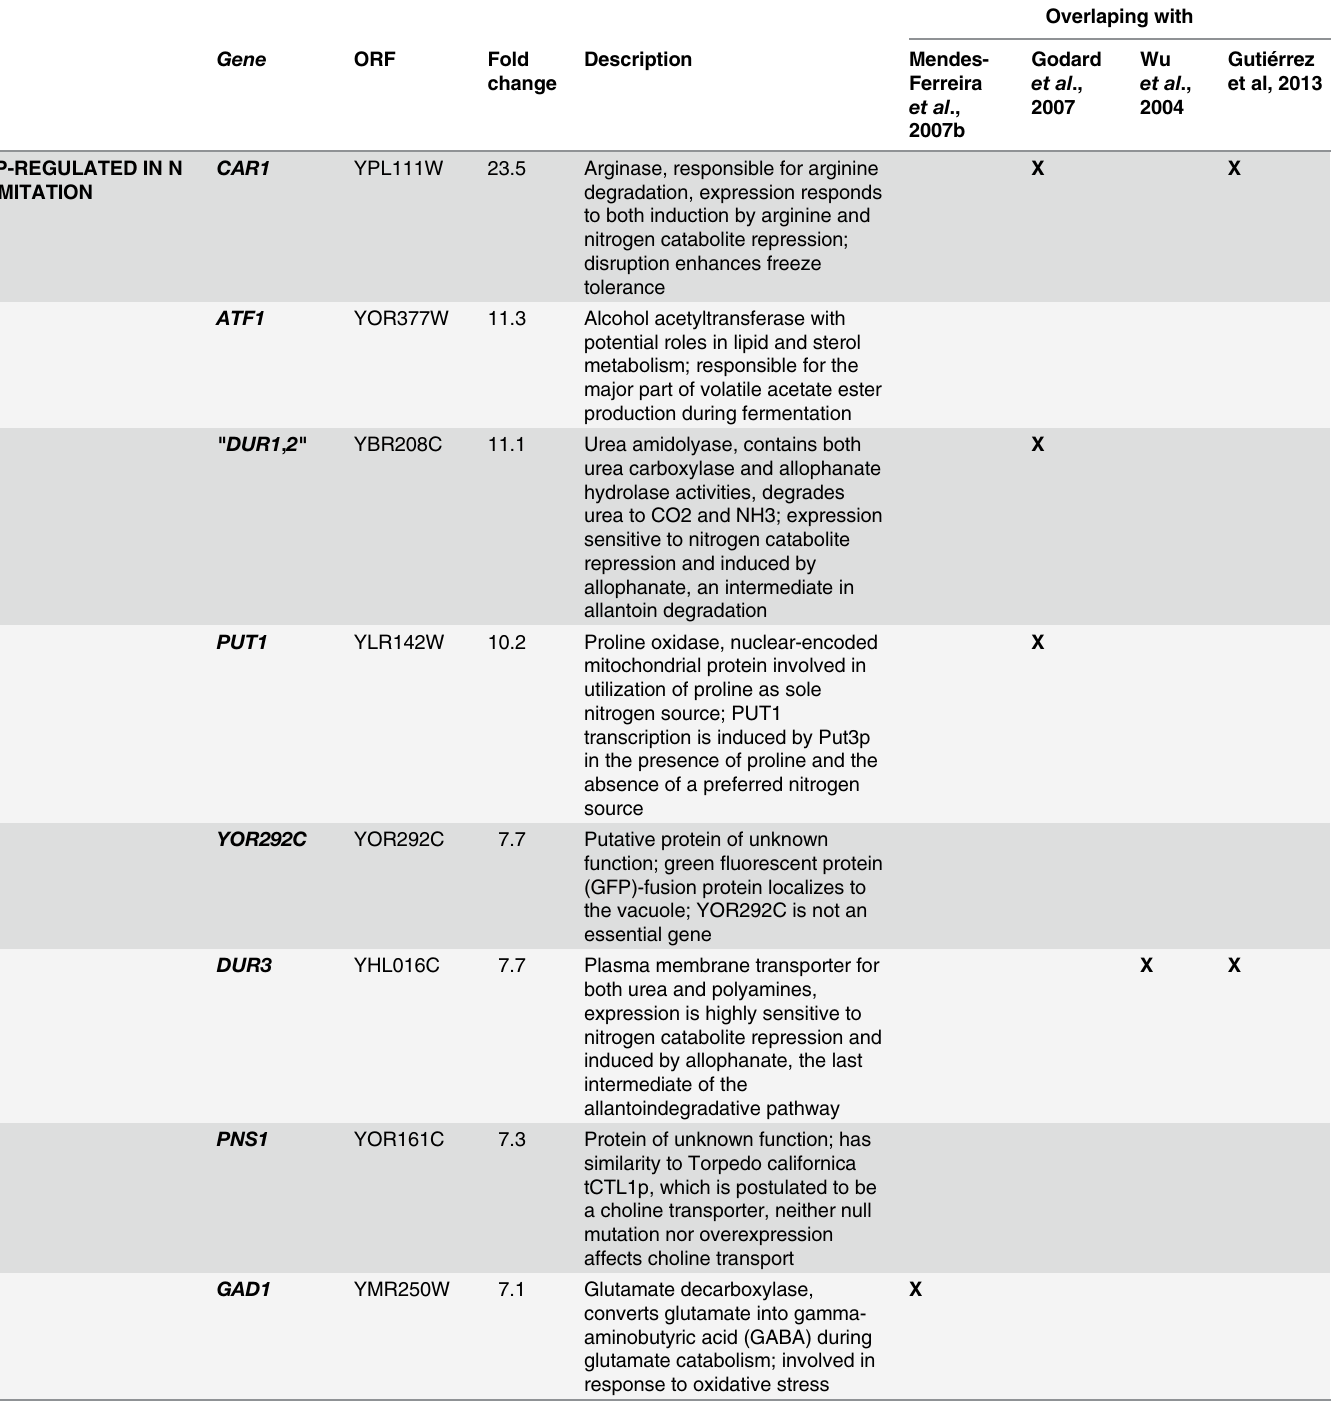
Table 1. List of genes up- and down-regulated at least 4-fold in nitrogen limited conditions, their correspondent description and the overlapping with other